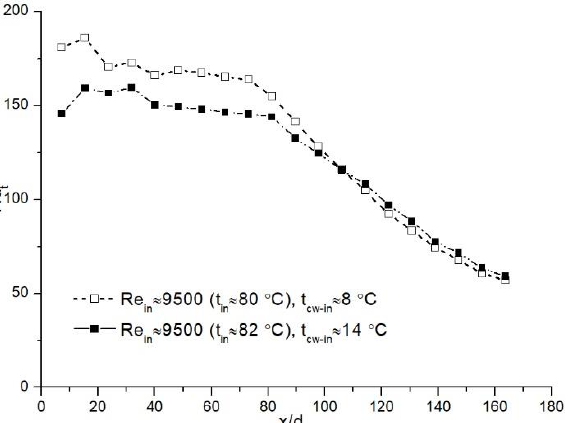
Figure 9. Distribution of the local Nu t in the heat exchanger at Re in ≈ 9500 and at different cooling water inlet temperatures.